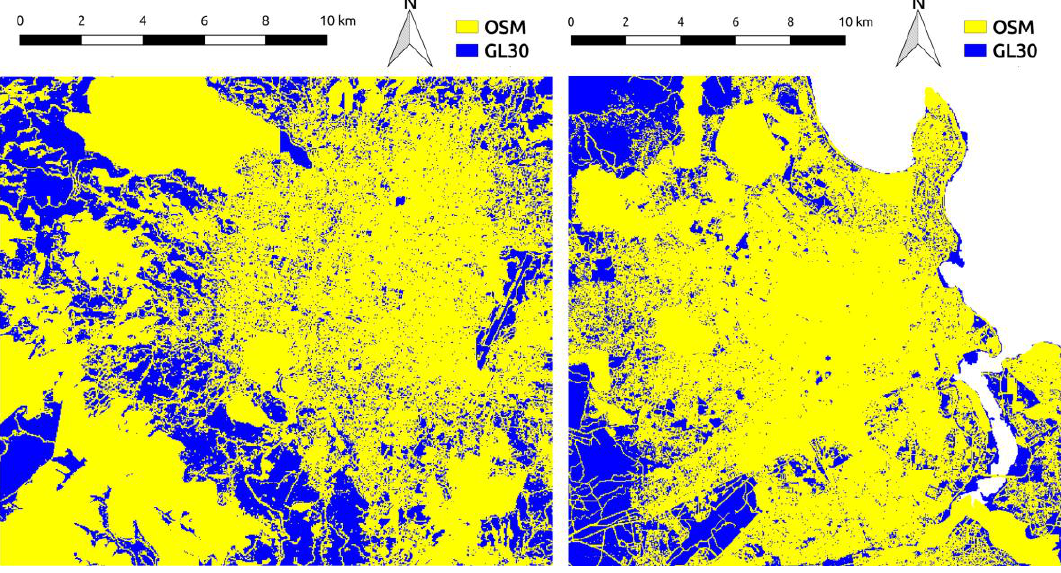
Table 10. User’s accuracy (UAc), producer’s accuracy (PAc) and overall accuracy (OAc) obtained for the GL30 and updated GL30 for both study areas.